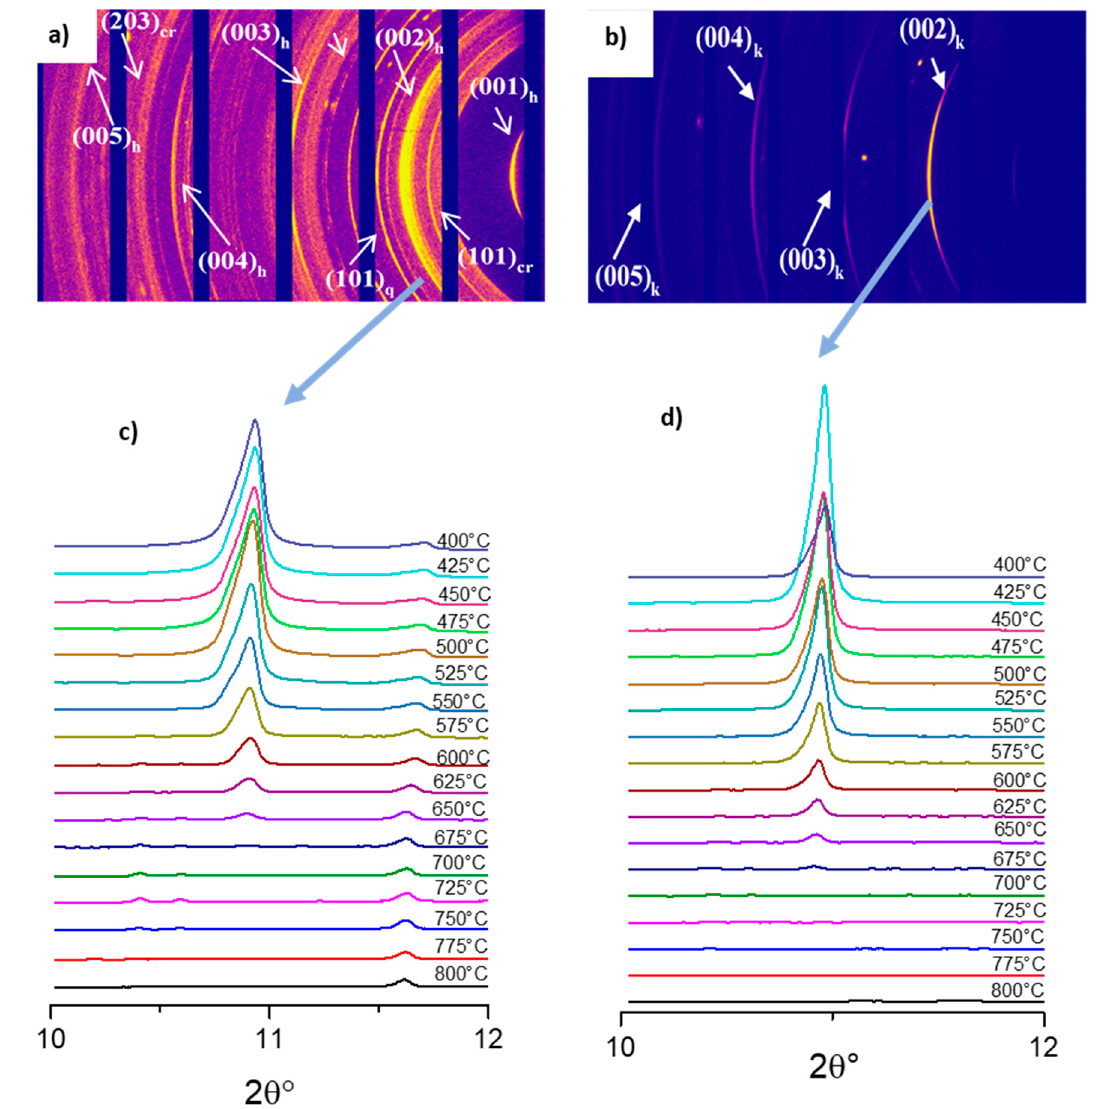
Figure 6. ( a , b ) Debye–Scherrer diffraction rings recorded at room temperature under an incidence angle equal to the (002) planes Bragg angle, for H100 and KRG100 respectively. ( c , d ) One-dimensional XRD patterns of (002) of H100 and KRG100, respectively, during dehydroxylation. According to the dehydroxylation sequences described by Pt á ˇcek at al. [20], the as-obtained results were discussed. Considering the (002) peak evolution presented in Figure 8, the plateau that precedes the intensity decrease could be assigned to the delamination stage. Thereafter, the end of the delamination overlapped with the dehydoxylation up to the total disappearance of the (002) peak of kaolinite or halloysite. From the aforementioned assumptions, the inflexion point could be considered as the characteristic beginning of the superposition between the delamination and dehydroxylation stages. The critical temperature derived from the sigmoid fitting indicated a similar trend for both ◦ KCS100 and H100. Hence KRG100 exhibited the lowest critical temperature (Tc ≈ 525 C). The mixture with halloysite did not significantly a ff ect the initial